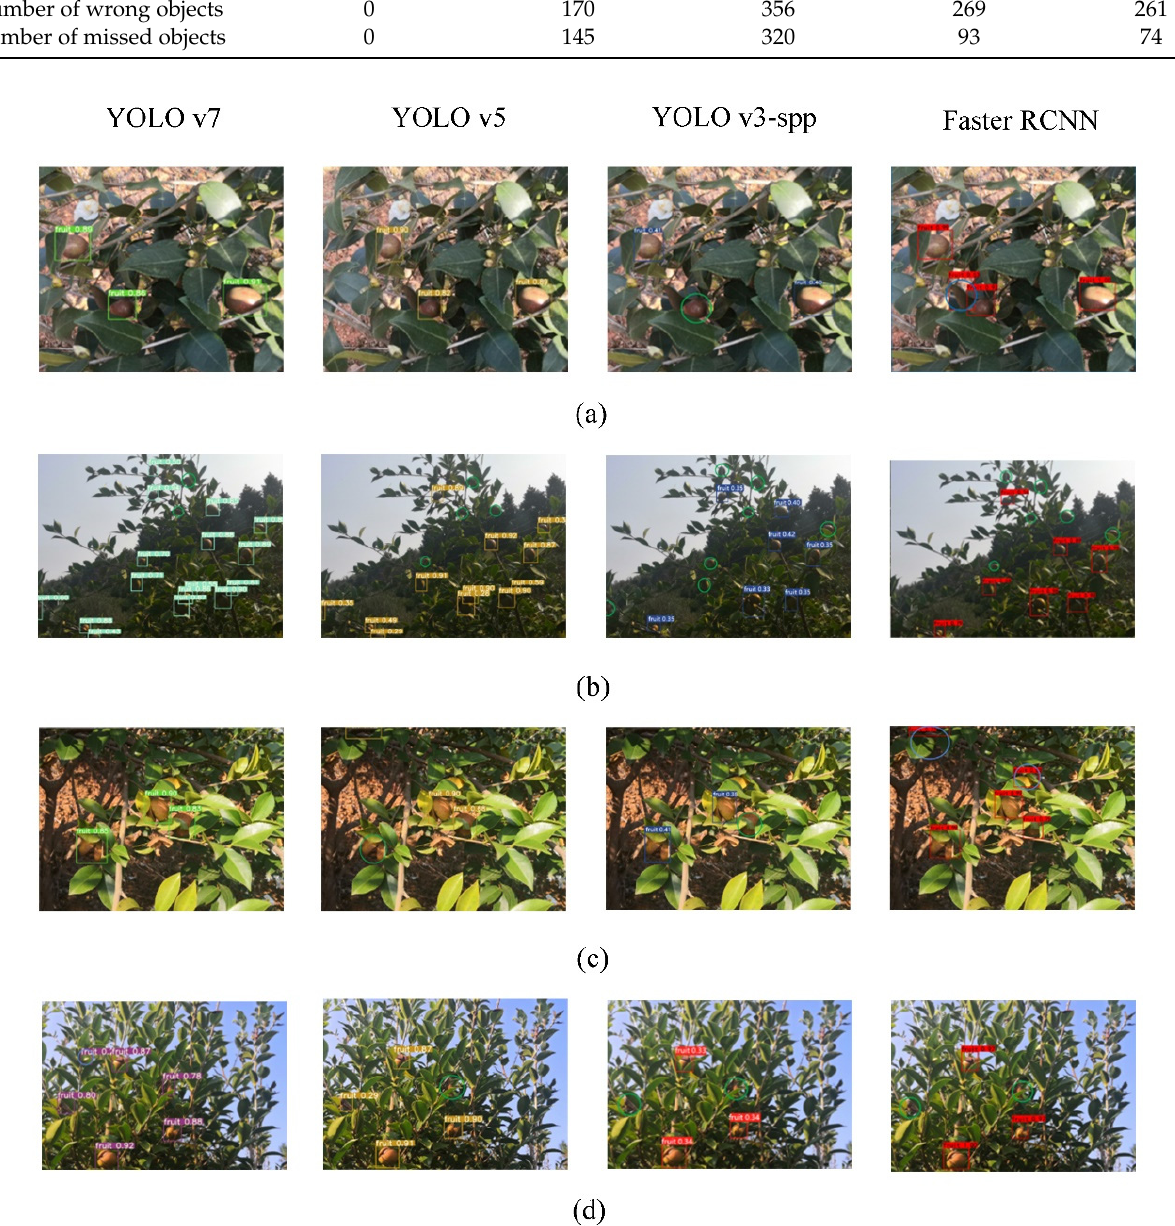
Figure 9. Examples of the detection results of four network models in a variety of complex scenes in test set. ( a ) sidelight angle; ( b ) backlight angle; ( c ) Slightly occlusion; ( d ) Heavy occlusion.